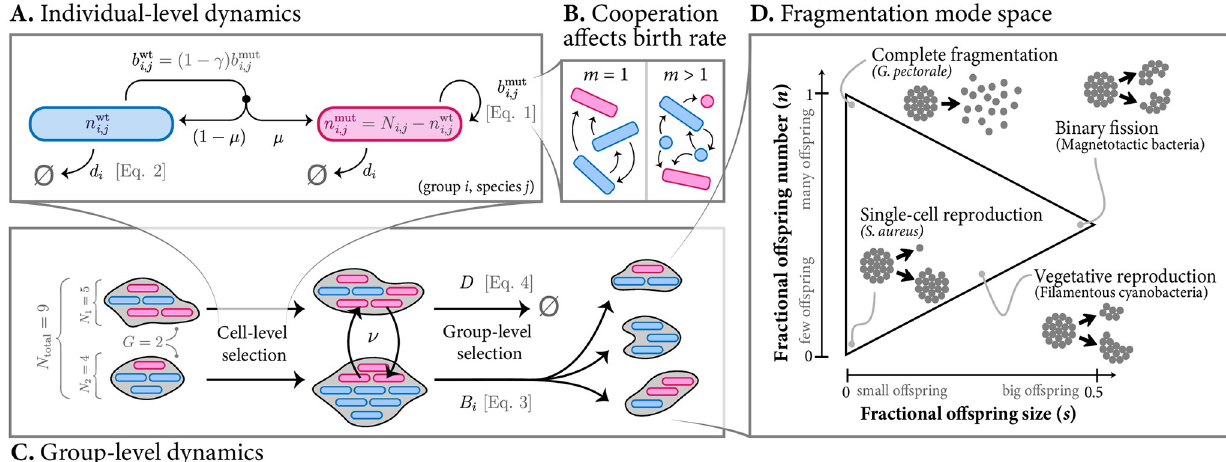
Fig 1. Illustration of the main model ingredients. We consider a community consisting of a varying number G of multicellular groups. Dynamics unfolds via simultaneous stochastic birth-death processes at both the individual level ( A ) and the group level ( C ). A : Each group i is composed of N i cells, of which are wild-type (blue), and the remaining n mut are mutants (red). The birth rate of mutants is given by b mut N i , j cells belong to species j . Of these, a number n wt i ; j i ; j i ; j (Eq 1); the birth rate of wild-type cells is b wt ¼ ð 1 (cid:0) g Þ b mut , where γ is the cost of cooperation. Mutations occur at birth with a probability μ . All cells in the i ; j i ; j group have the same death rate, d i (Eq 2). B : Cooperation on the part of wild-type cells (e.g., by producing public goods—indicated with arrows—that are consumed by other cells) determines cell birth rate. In the single-species case ( m = 1) cooperation occurs between individuals of the same species. In the multi-species case ( m > 1) cooperation occurs across species (e.g., cross-feeding); species are denoted by differently-shaped icons. C : Groups in the community also undergo a birth-death process. (Group-level and individual-level dynamics unfold simultaneously, but they are depicted sequentially for simplicity.) Group death (termed ‘extinction’) occurs at a rate D (Eq 4), and group birth (termed ‘fission’ or ‘fragmentation’) occurs at a rate B (Eq 3). At a i rate ν , cells can also migrate between groups. D : When a fission event occurs, the parent group fragments into offspring groups. The number and size of offspring groups is determined by the group’s fragmentation strategy. All possible fragmentation strategies in our model can be described using a two- dimensional phase space. Two parameters ( s and n ) determine the expected size and number of offspring, respectively (as a fraction of the number of cells in the parent group). Cartoons exemplify some modes of fragmentation. We refer to the three corners of the triangle (complete fragmentation, single-cell reproduction, and binary fission) as archetypal modes of